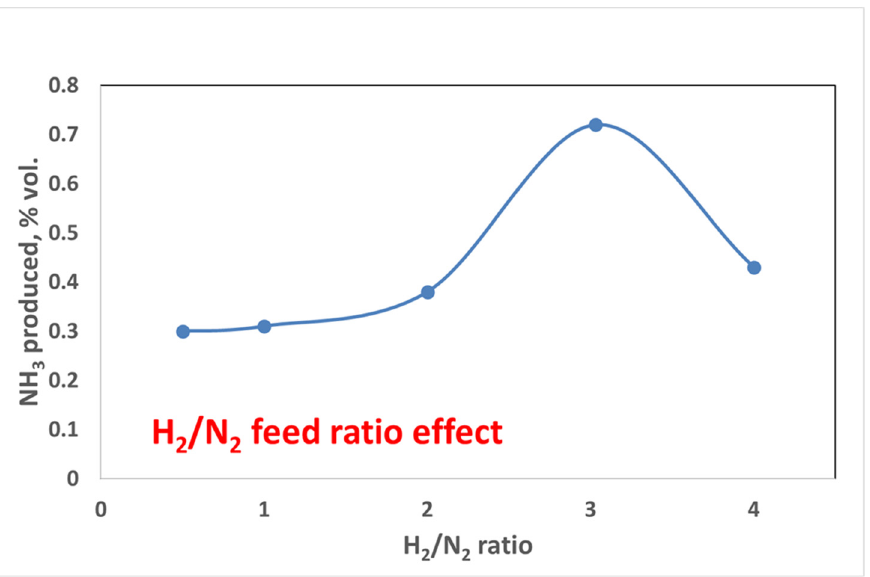
Figure 11. Feed ratio effect at the same operating conditions for the Ni-Zeolite 13X catalyst, 0.5 L (g cat h) − 1 , P = 66 W.